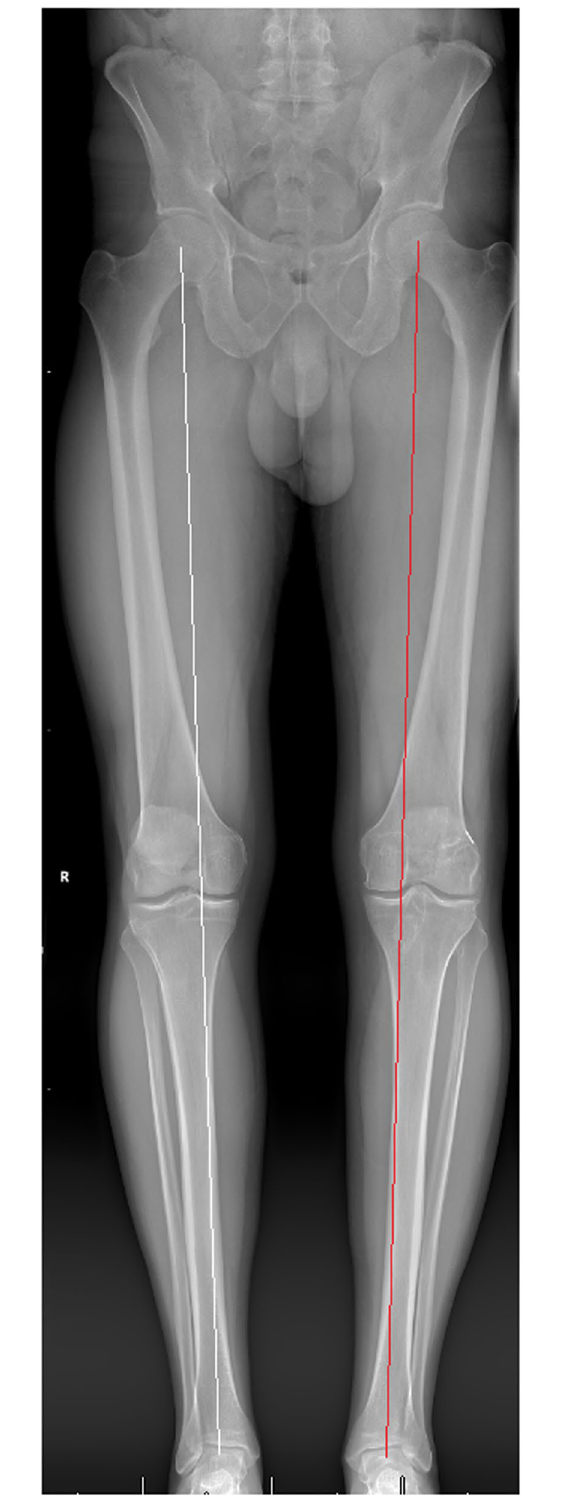
Fig. 11 A pre-operative standing mechanical axis radiograph demonstrating slight native varus